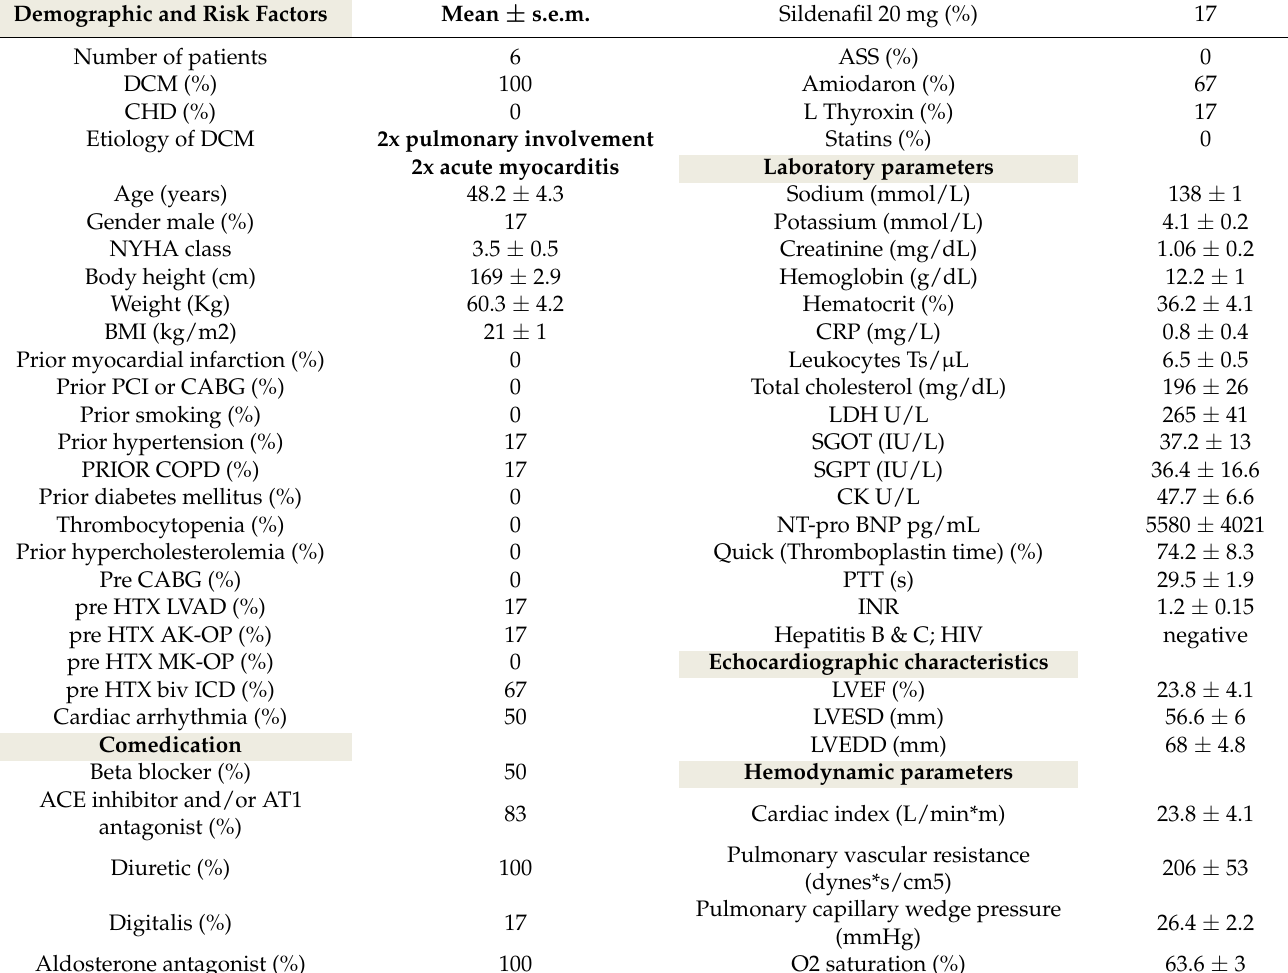
Table 1. Clinical data of six patients with a cardiac granuloma who had undergone a heart transplantation (HTX). Five patients were female and one was male. All patients developed the phenotype of a dilated cardiomyopathy (DCM) and none showed signs of coronary heart disease (CHD). Two of them revealed a pulmonary involvement of sarcoidosis and further two suffered from acute myocarditis. Mean left ventricular ejection fraction (LVEF) was lower than 25%. Abbreviations are explained in the following. NYHA—New York Heart Association; PCI—percutaneous coronary intervention;